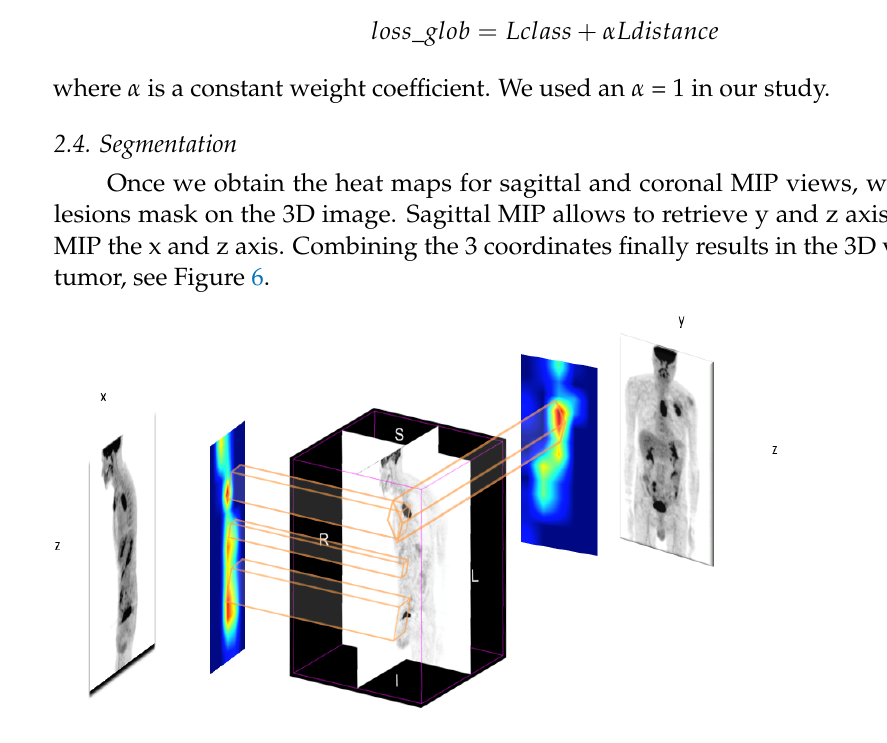
Figure 6. Segmentation: the 3D tumor region from the two 2D heat maps. Coronal heat map allows to retrieve y and z axis, while sagittal heat map return x and z axis. The tumor is selected by the intersection of the two heat